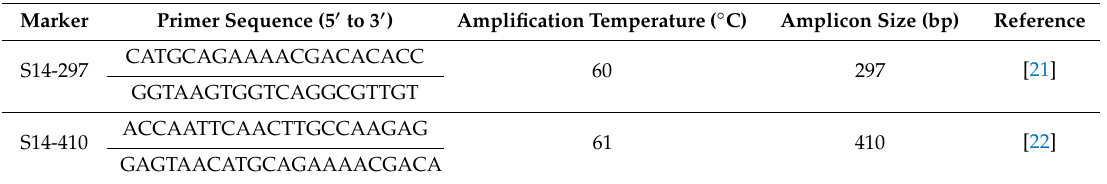
Table 1. Primer sequences and PCR conditions used for Lr54 + Lr37 marker identification on 2S k chromosome.